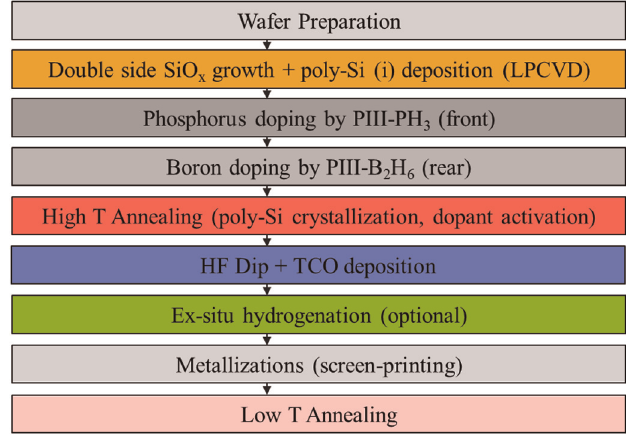
Fig. 9. Fabrication process of double-side poly-Si/SiO x based passivated contacts